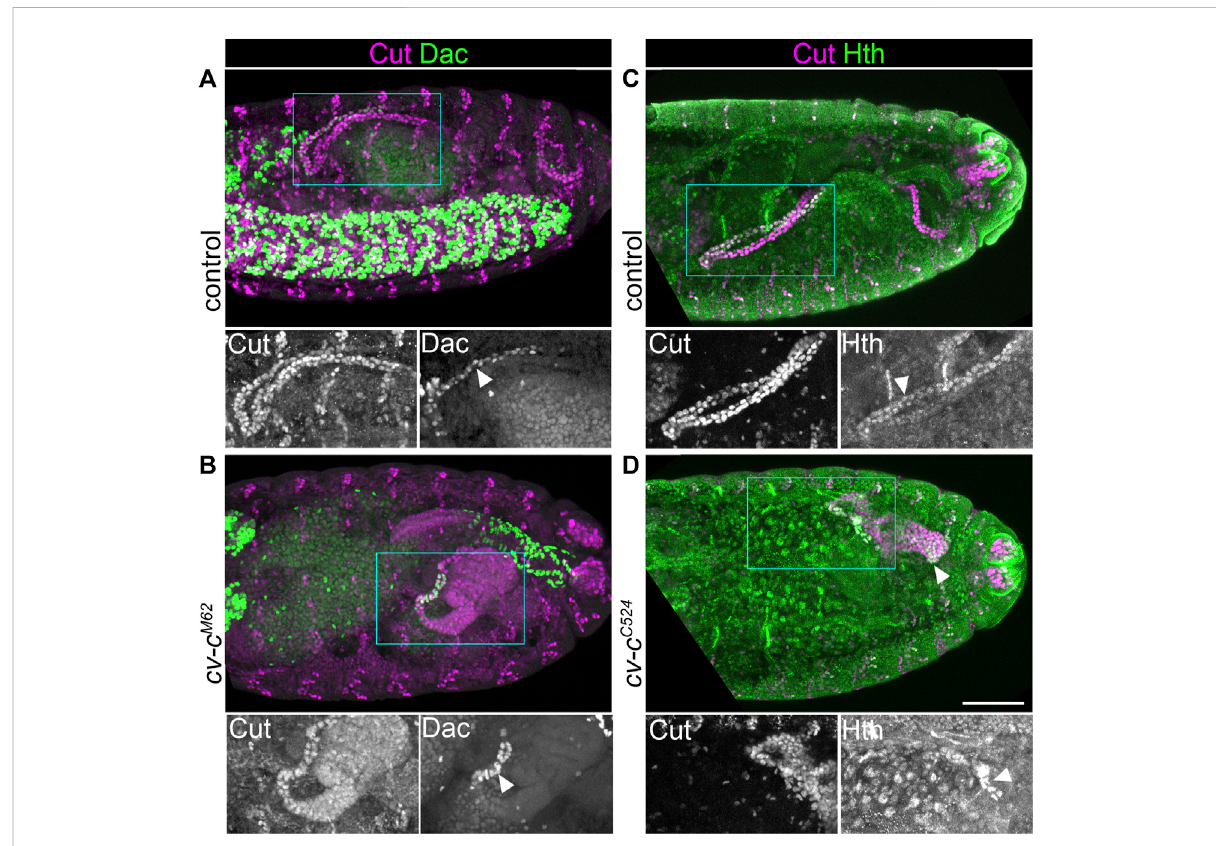
FIGURE 5 Reducing Malpighian tubulelengthdoesnotleadtoinhibition ofdistaltranscriptionfactorexpression. (A,B) ~Stage 16embryos stainedtoshow MpT nuclei (anti-Cut) and the nuclei of cells from the distal MpT segment (anti-Dac, arrowheads). (C,D) ~Stage 16 embryos stained to show MpT nuclei (anti-Cut) and the nuclei of cells from the distal MpT segment (anti-Hth, arrowheads). (A) Control cv-c M62 /+ or +/+ embryo. (B)